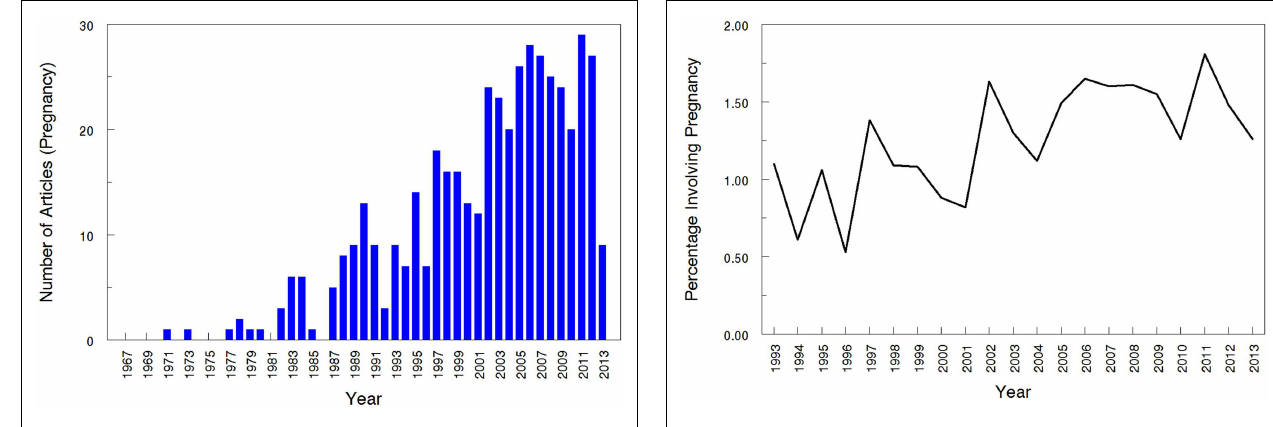
FIGURE 3 | Proportions of pharmacokinetic clinical trials conducted in pregnancy .The year 2013 includes those articles index for MEDLINE by August 31, 2013 only.This figure shows the percentage of pregnancy pharmacokinetic articles compared to all pharmacokinetic articles published since the early